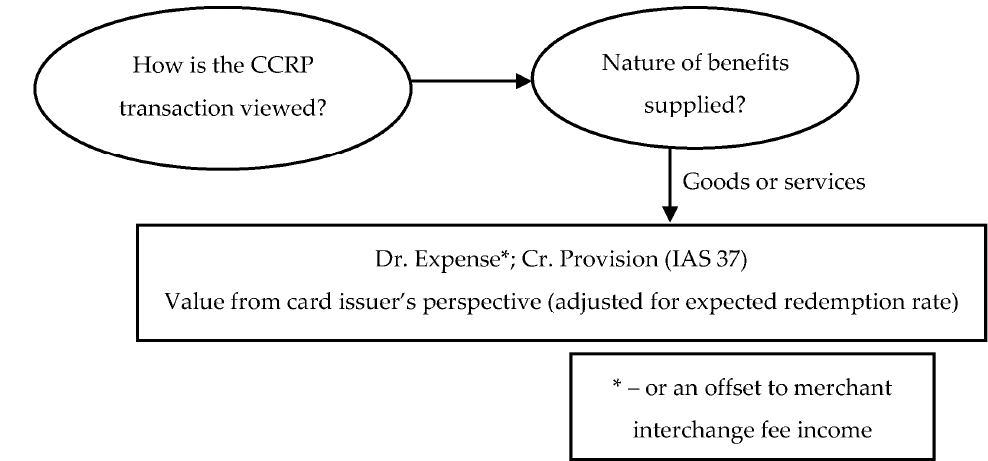
Figure 1. Accounting for a CCRP transaction viewed as a marketing tool when the nature of benefits is goods or services.